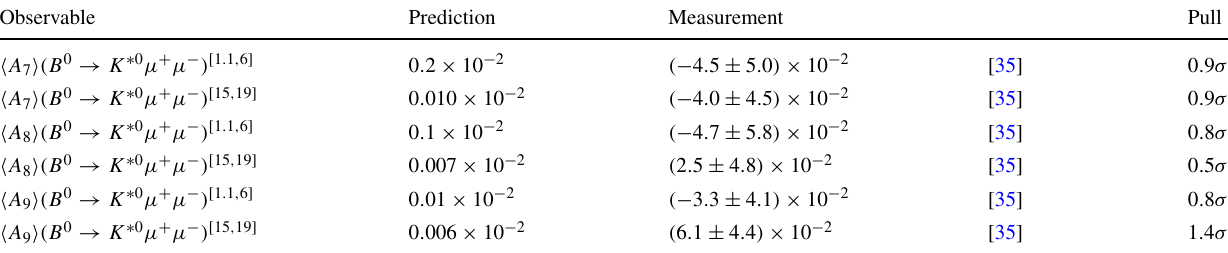
Table 9 B decays CPV observables